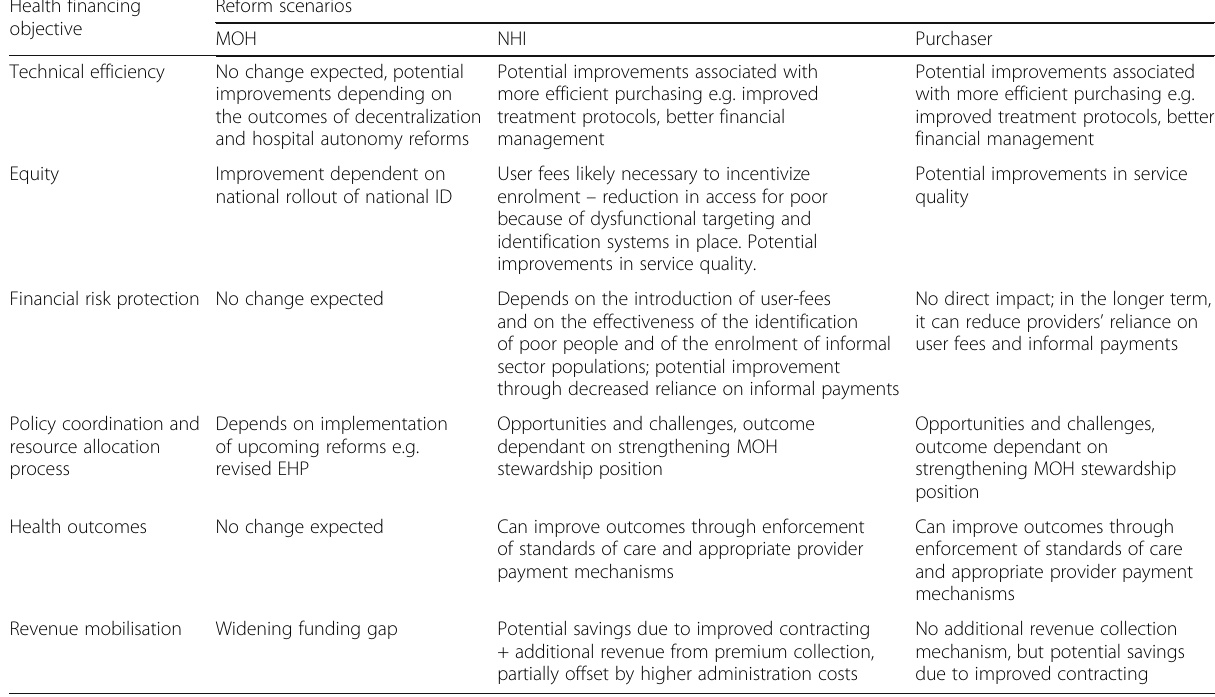
Table 4 Health financing benchmarking matrix Health financing